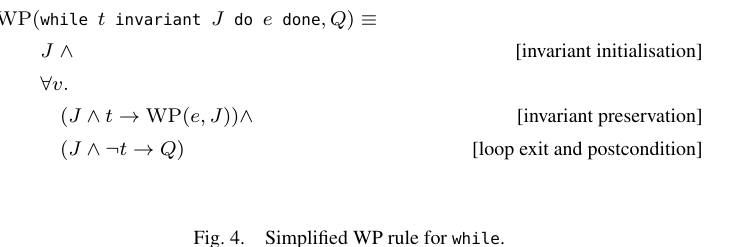
Fig. 3. Some WP rules.